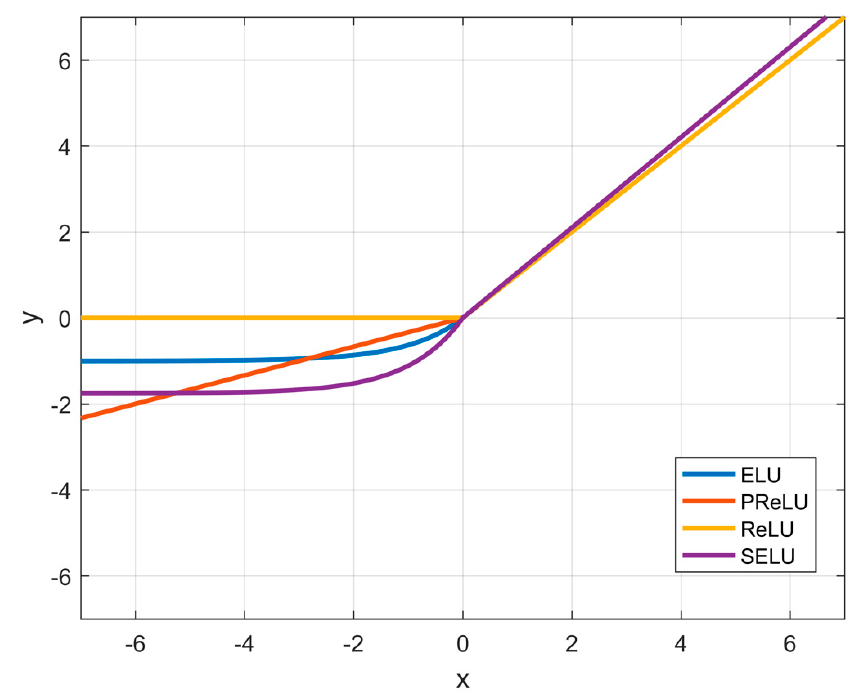
Figure 3. Functions including exponential linear unit (ELU), parametric rectified linear unit (PReLU), rectified linear unit (ReLU), and scaled exponential linear unit (SELU).